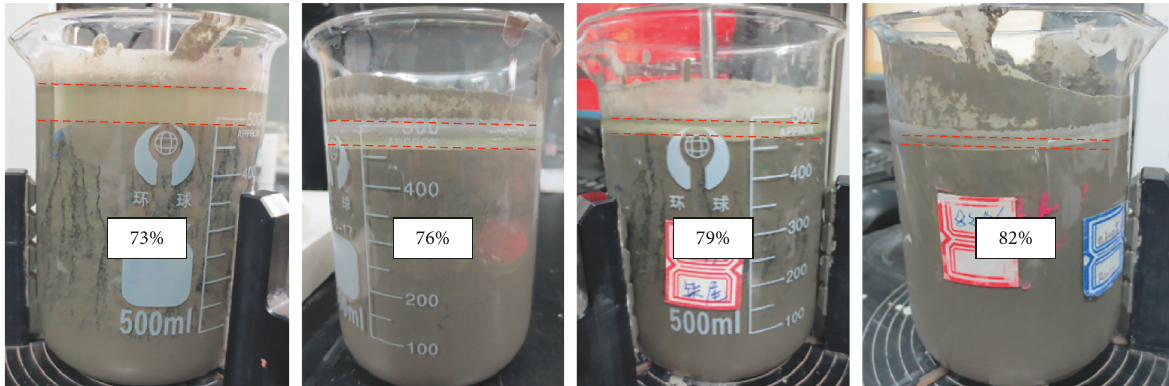
Figure 5: Practical bleeding situation of slurry (with different mass concentrations of 73%, 76%, 79%, and 82%) after the shear rate